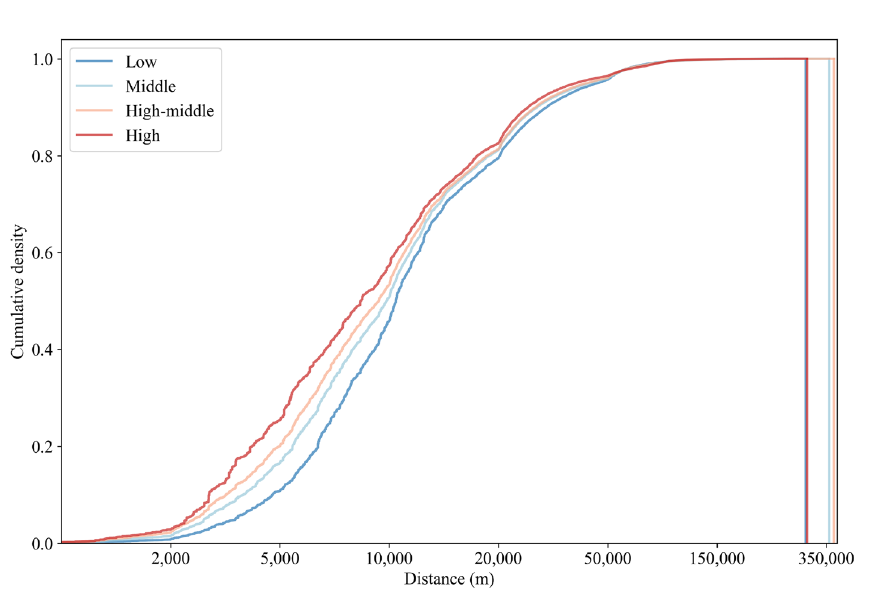
Figure 6. Distribution of trip distances across income